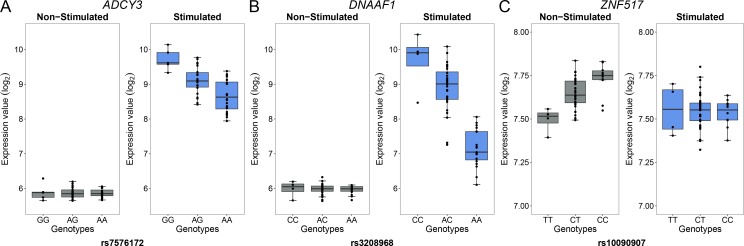
Examples of genes with reQTL likely to impact susceptibility to leprosy.Examples of three reQTL among genes found only in M. leprae sonicate stimulated cells or non-stimulated cells. For each gene ((A) ADCY3, (B) DNAAF1 and (C) ZNF517): the left panel corresponds to the expression of the gene in non-stimulated cells while the right panel depicts expression of the gene in stimulated cells. The gene identity is indicated above each pair of graphs. The gene expression level in log2 scale (y-axis) is plotted for each genotype (x-axis). Of note, reQTL for the ADCY3 and DNAAF1 genes have been found by other studies using distinct pathogens or molecules as stimuli, while the reQTL for ZNF517 is a newly identified reQTL [21, 22, 24, 26]. ADCY3 is among the most upregulated genes after stimulation with M. leprae antigens and has been identified as part of the T1R gene set signature identified by Orlova et al. [32]. The reQTL for DNAAF1 displays the strongest P value among the reQTL we identified.